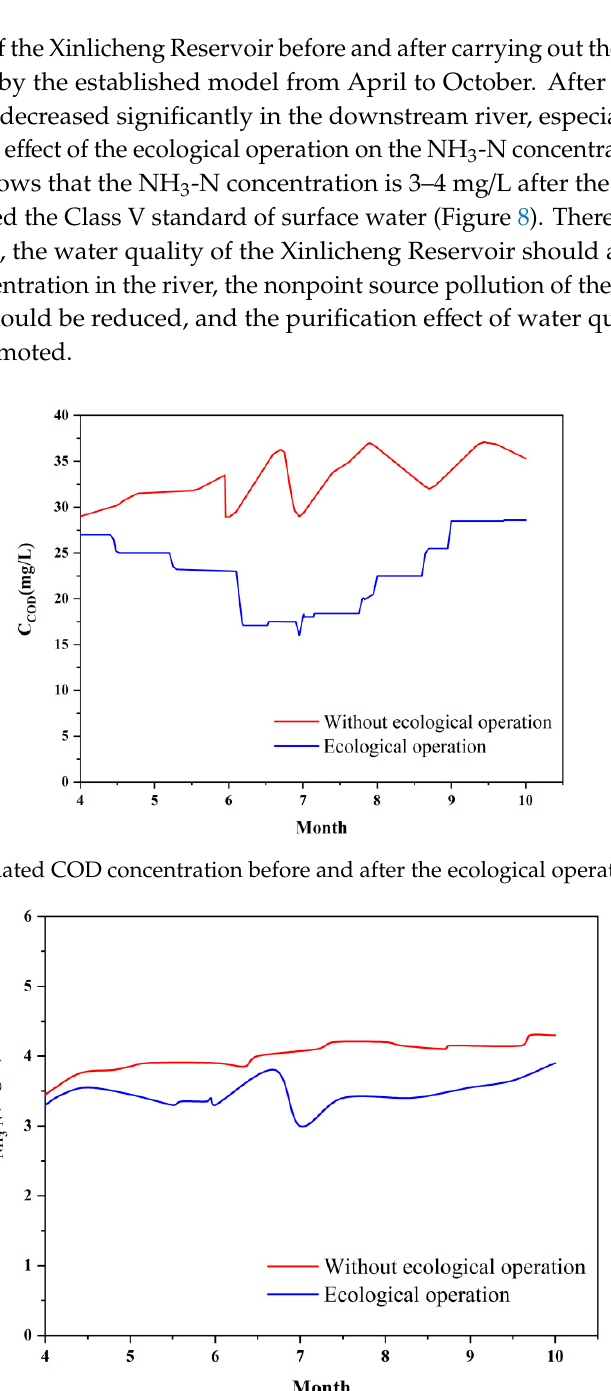
Figure 8. Simulated NH 3 -N concentration before and after the ecological operation scheme.